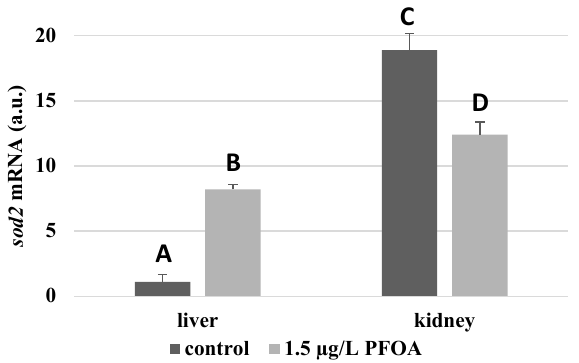
Figure 2. sod2 mRNA expression levels in the liver and kidney of T. newnesi exposed to PFOA and unexposed (the control group). Values (arbitrary units) are indicated as mean ± SD. Transcription levels were normalized to the gapdh housekeeping gene. Different letters correspond to significant statistical differences ( p < 0.05) among different means (Student–Newman–Keuls test), with ten specimens per experimental group.